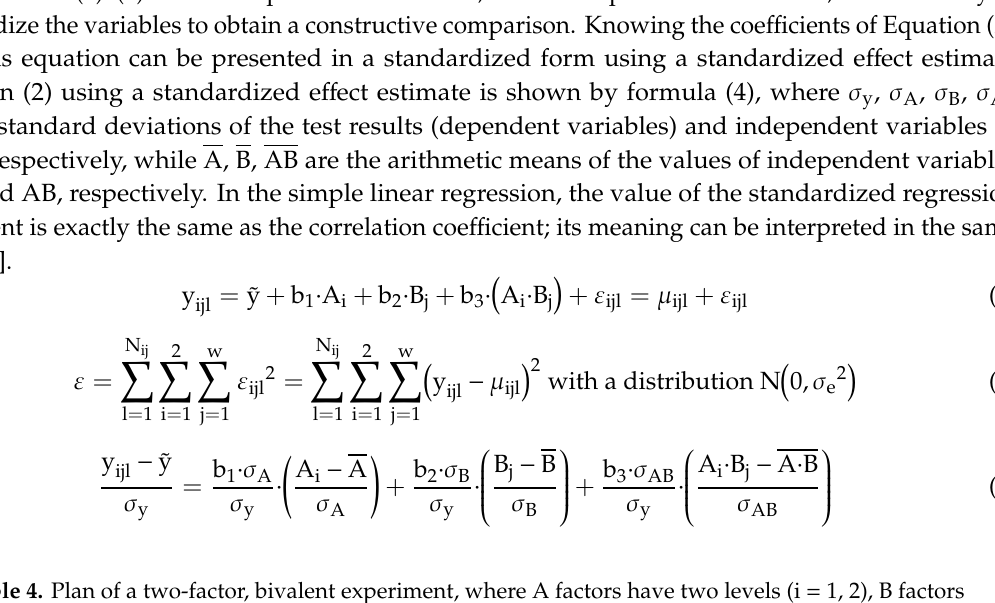
Table 4. Plan of a two-factor, bivalent experiment, where A factors have two levels (i = 1, 2), B factors have two levels (j = 1, 2), and “l” is the sample number for each level of A and B factors and varies from 1 to Nij. Main Factors Interaction Factors Mean NoE